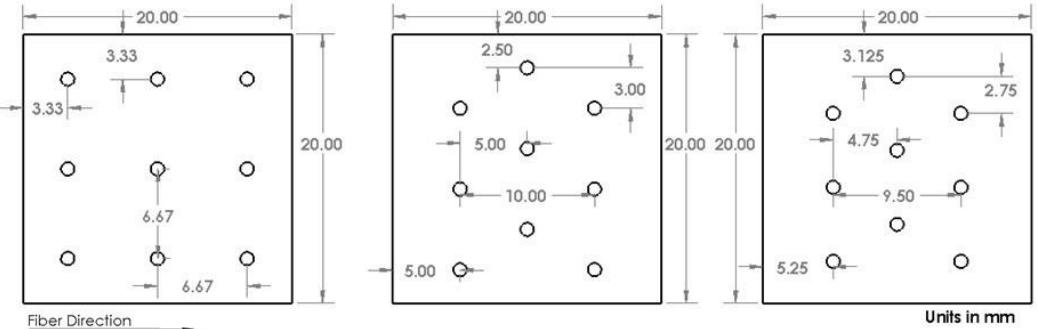
Figure 11. Diagrams of droplet grid guides used. From left to right: 1. square grid, 2. staggered grid, 3. tight-staggered grid.